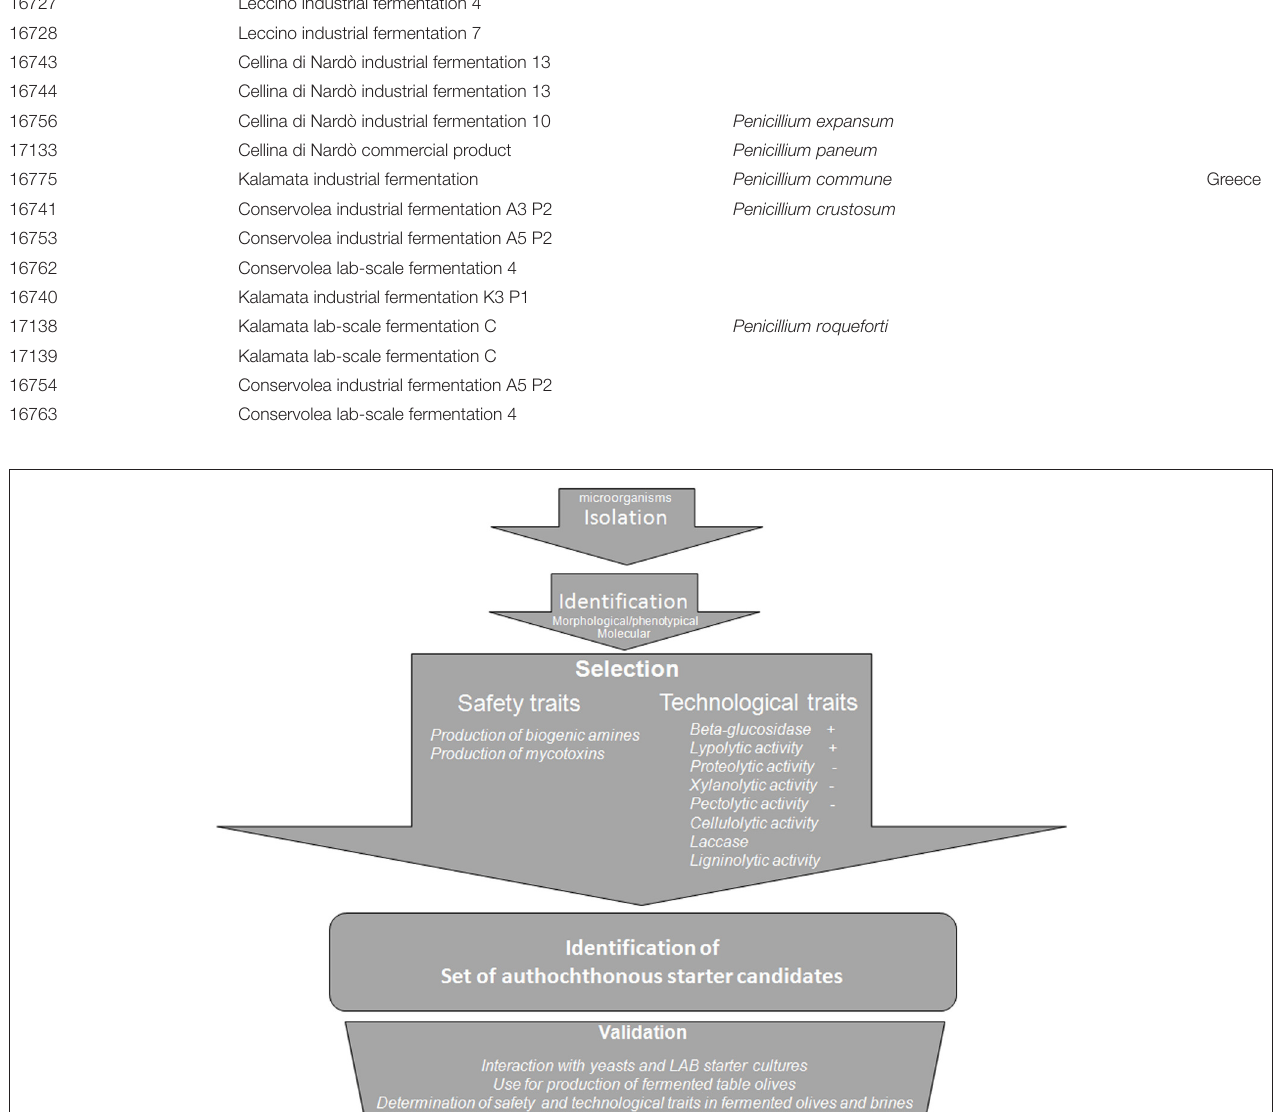
For the determination of the amino acids decarboxylation activities, the value 0 was used to indicate isolates that remained white, isolates surrounded by an intense purple halo were marked with the value 3, isolates producing intense blue halo with